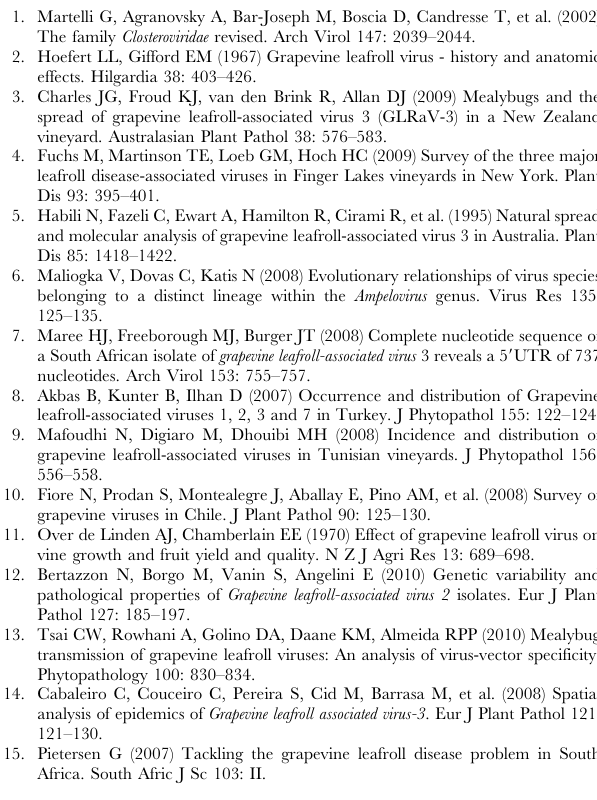
Figure S1 Diagrammatic summary of vineyard blocks sampled for GLRaV-3 variants. Vineyards without positive samples or with one infected plant were not included. Each letter (A through H) represents a different vineyard, blocks’ size (bars = 200 meters) and spatial location in relation to each other are accurate representations based on aerial photographs of blocks. Information per block, when available, includes block number as in Table S1, year of block establishment, and GLRaV- 3 variants present in each block and the respective number of positive samples. For example, vineyard ‘C’ had two blocks surveyed, one established in 1994 ( # 17) and another in 2008 ( # 18), block # 18 had no positive samples but # 17 was positive for GLRaV-3a, -c, and had -3a/c mixed infections. Table S1 Information on Napa Valley vineyards and blocks surveyed for GLRaVs. Subdivisions indicate different vineyards and the blocks therein. Table S2 Primer sets and multiplex conditions for detection of grapevine leafroll-associated viruses at the species level. All primers were designed by Osman et al. (2007, J. Virol. Methods 141: 22–29).